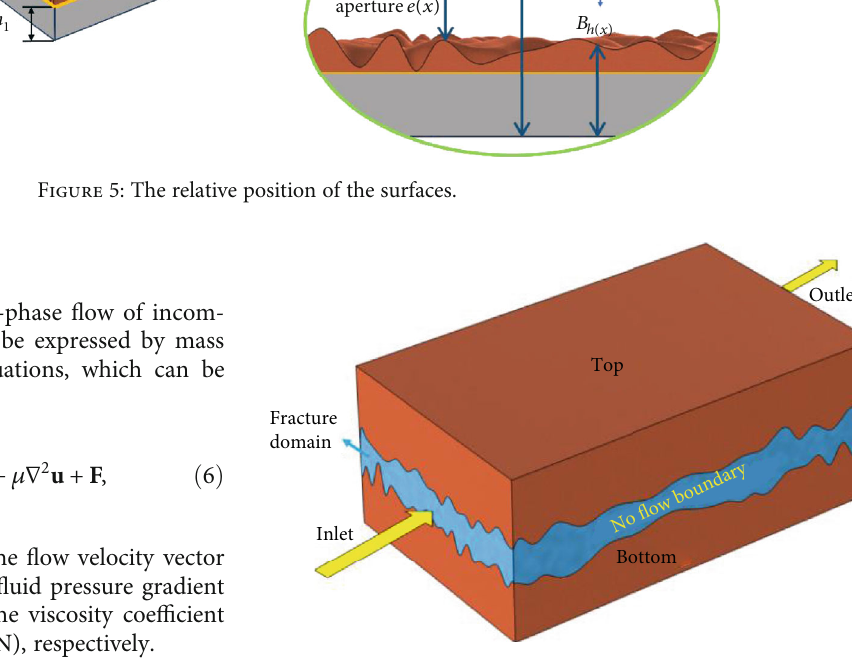
Figure 6: Inversion of the fracture